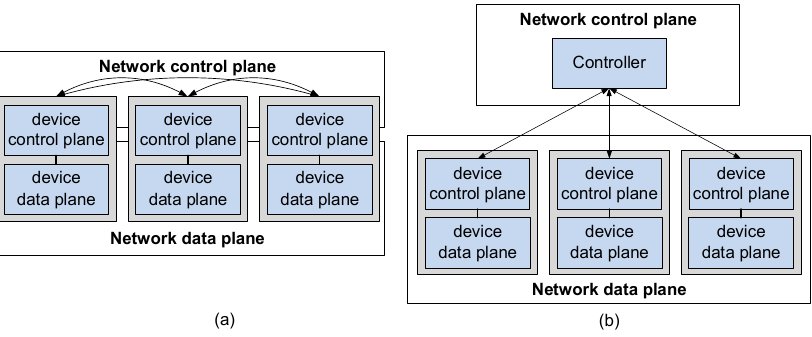
Figure 1. ( a ) Traditional network architecture. ( b ) SDN-based network architecture.